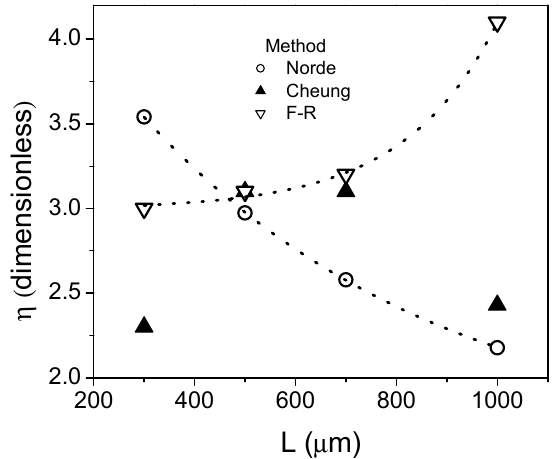
Figure 3. Comparison of the extracted values of the ideality factor.